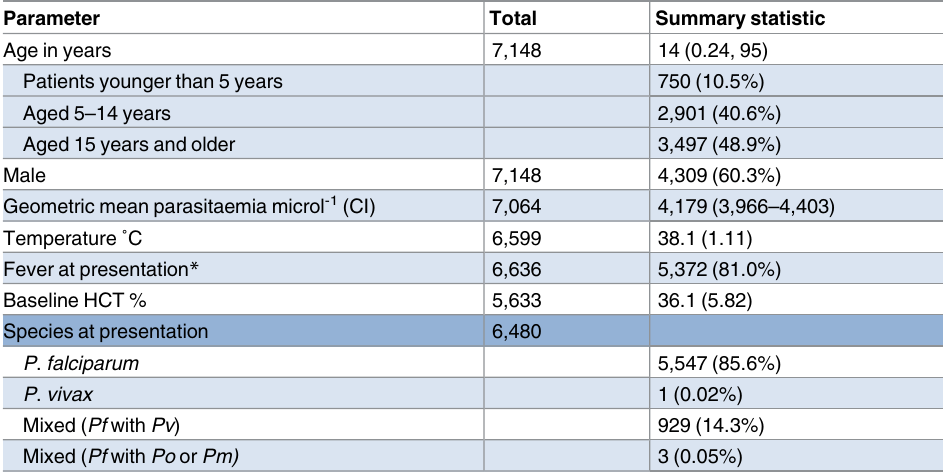
Table 2. Trial participant baseline characteristics.